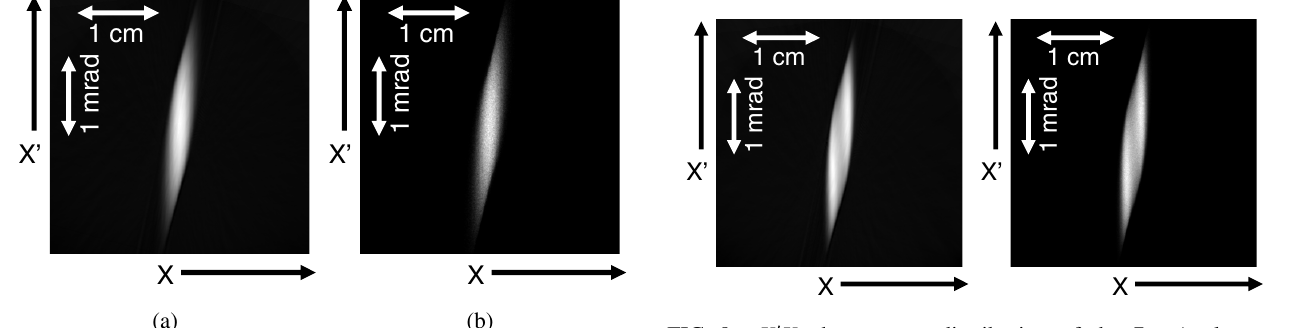
FIG. 8. X 0 X phase space distribution of the 7 mA electron beam starting with a hollow velocity distribution: (a) by tomog- raphy; (b) by direct WARP simulation.